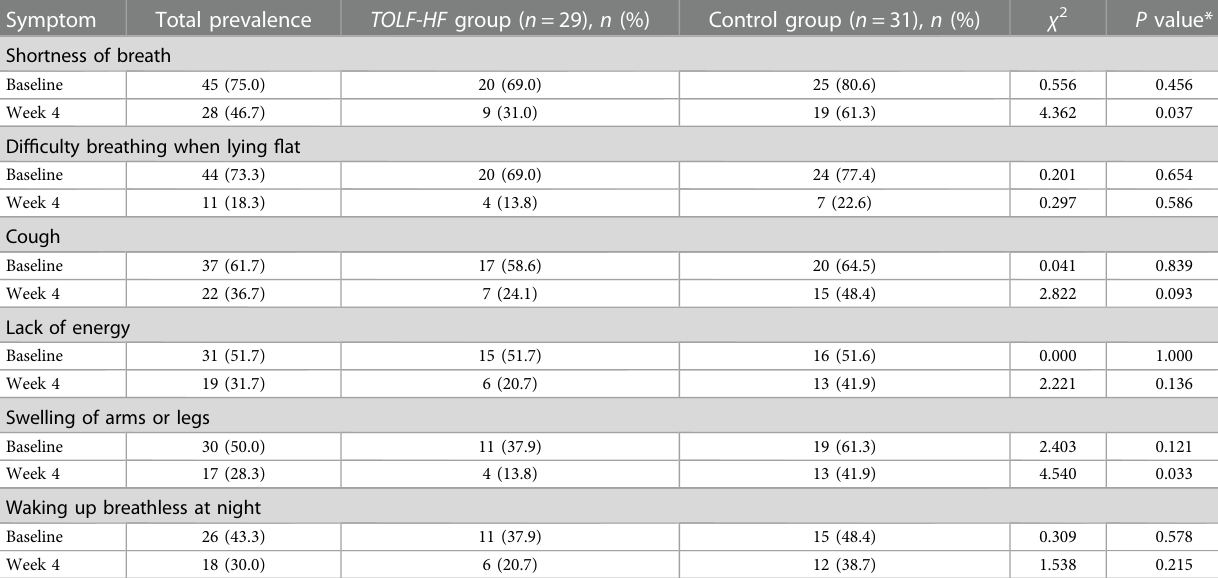
TABLE 3 Comparison of symptom prevalence at baseline and week 4 between the groups.